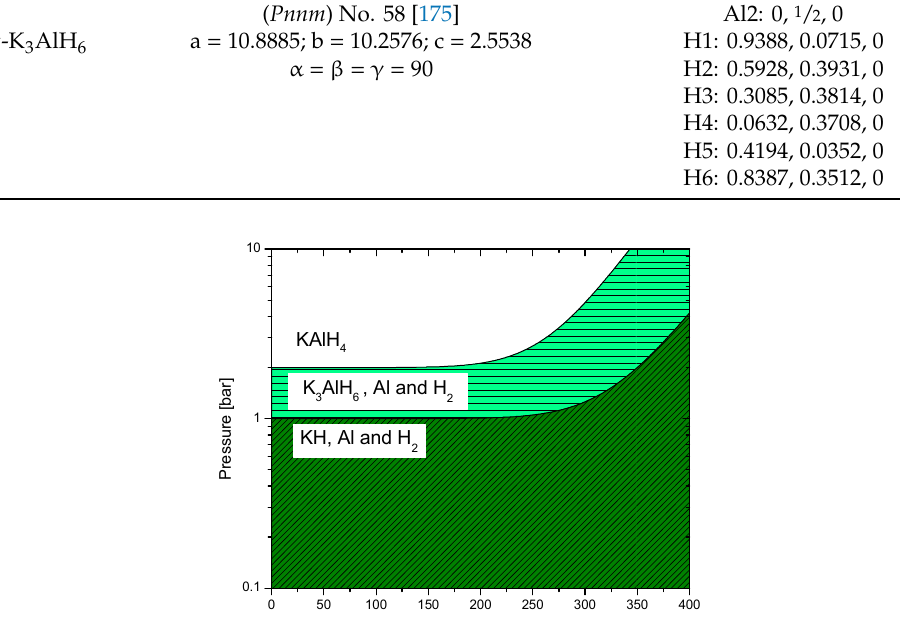
Figure 9. Crystal structure of potassium alanates and their calculated diffraction patterns ( λ = Cu k α 1 ).